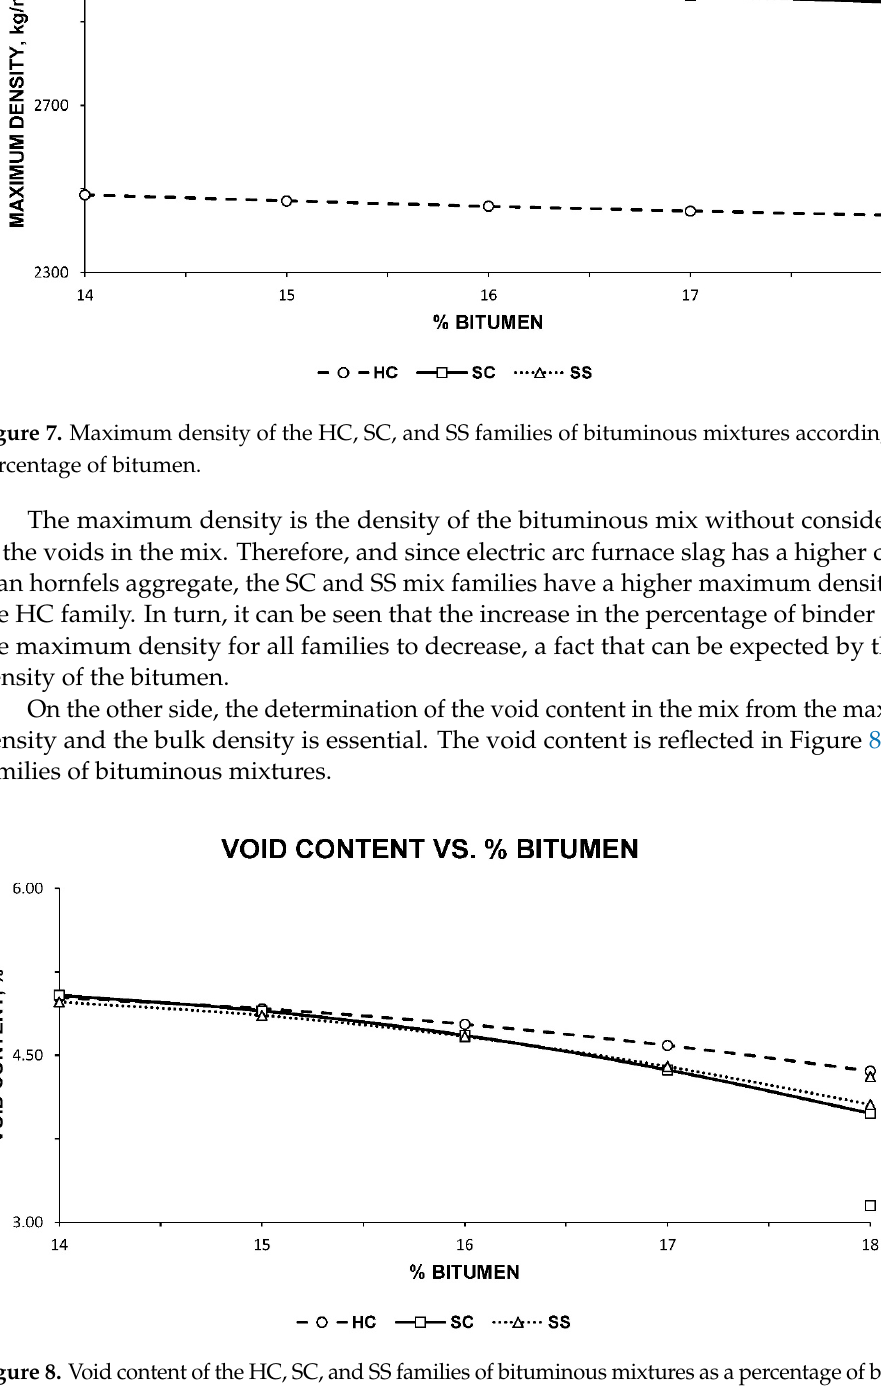
Figure 8. Void content of the HC, SC, and SS families of bituminous mixtures as a percentage of bitumen. The void content in the mix of the three families of bituminous mixtures is very sim ‐ ilar, with small variations in the highest percentages of bitumen between the HC mix and the SC and SS mixes. However, these variations are negligible. It should be noted that the content of voids in the mix is one of the properties that most influences the quality of the bituminous mix, since it conditions its drainability, its roughness for the friction of the tire